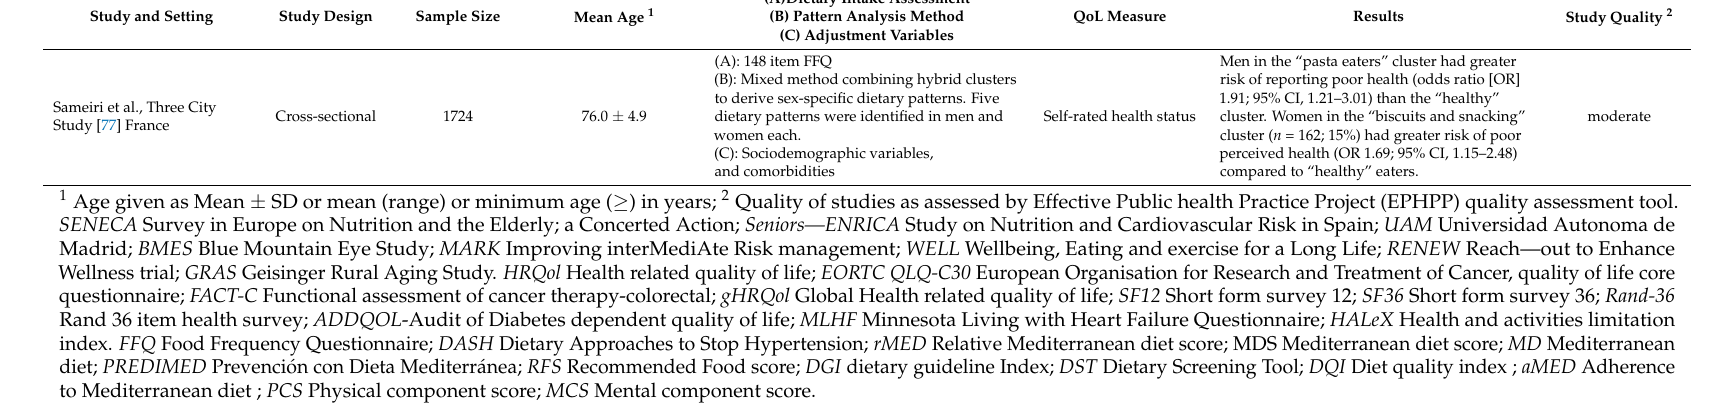
(A): 148 item FFQ (B): Mixed method combining hybrid clusters to derive sex-specific dietary patterns. Five dietary patterns were identified in men and women each. (C): Sociodemographic variables, and comorbidities